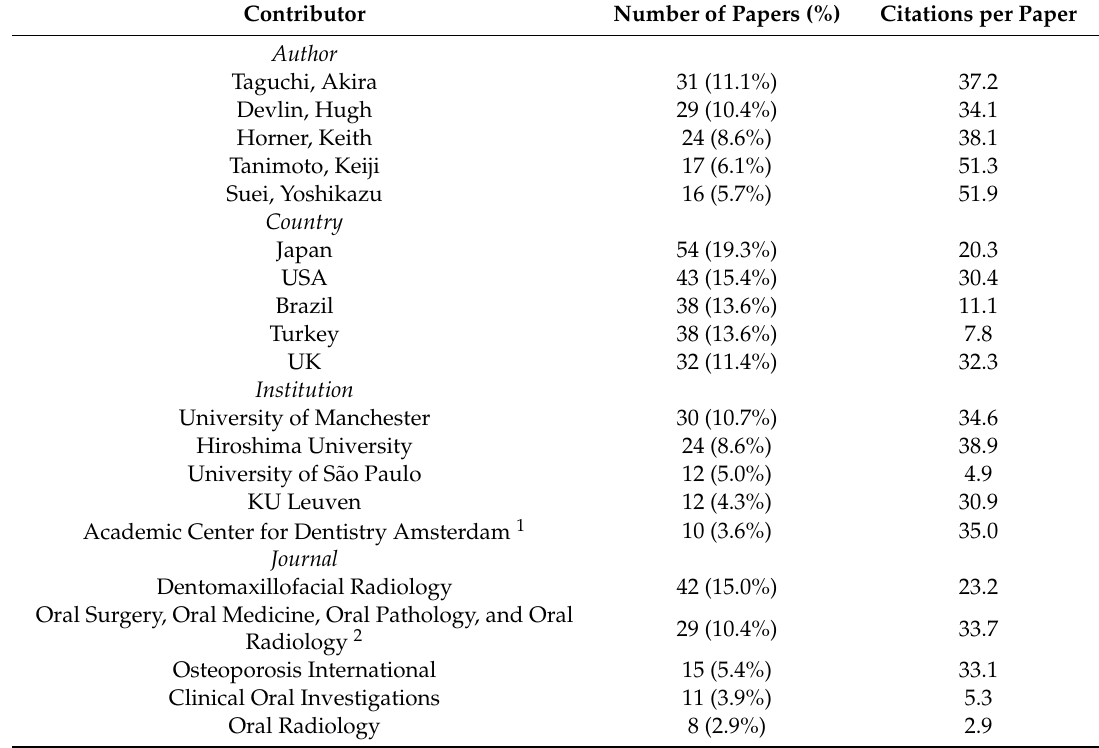
Table 1. The top 5 major contributors in terms of author, country, institution, and